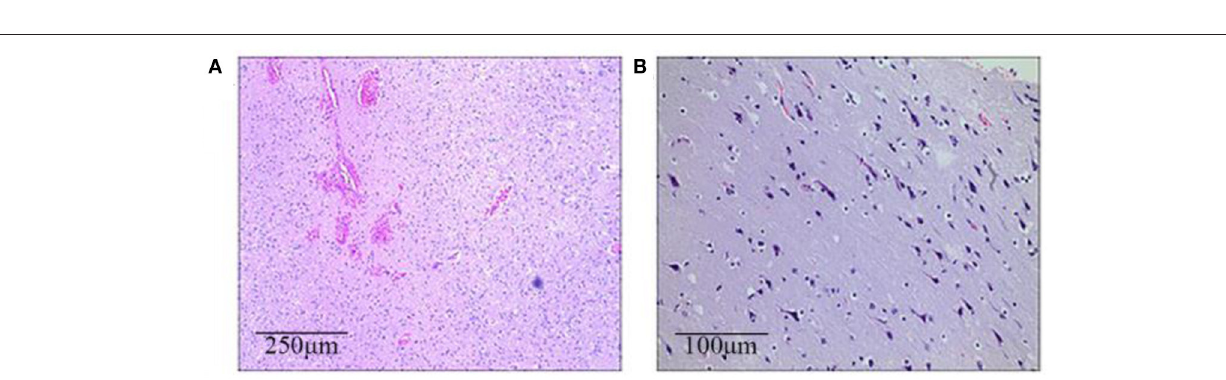
FIGURE 4 | The brain histopathological results (HE staining). (A) Case 1 (the left frontotemporal lobe): Immature neurons, proliferated glial cells, and proliferated vessels with dilation and hyperemia can be seen in a light microscope. (B) Case 2 (the right frontal lobe): Neuronal shrinkage and degeneration can be seen, with the appearance of immature neurons and mild proliferation of glial